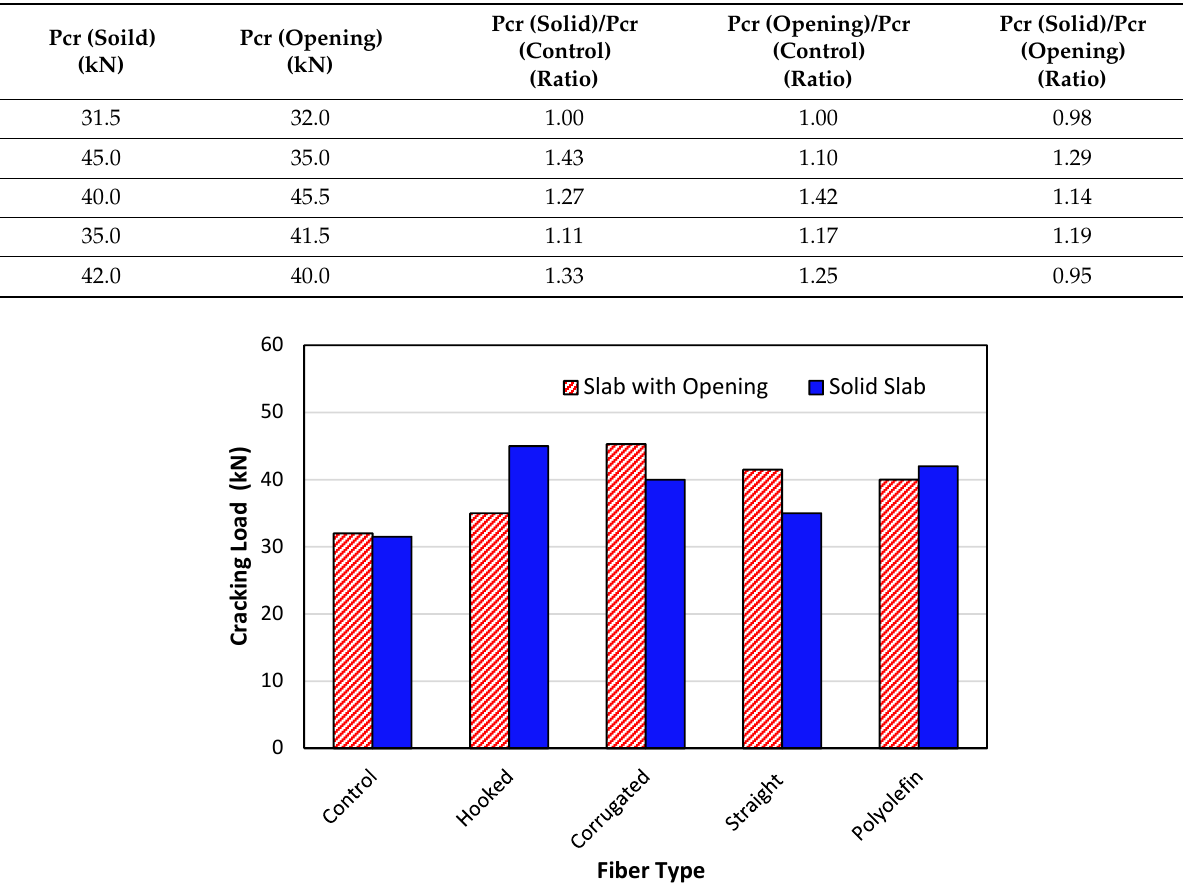
Figure 8. Effect of fiber type on cracking load. Table 7. Cracking and ultimate load of specimens for solid slab.